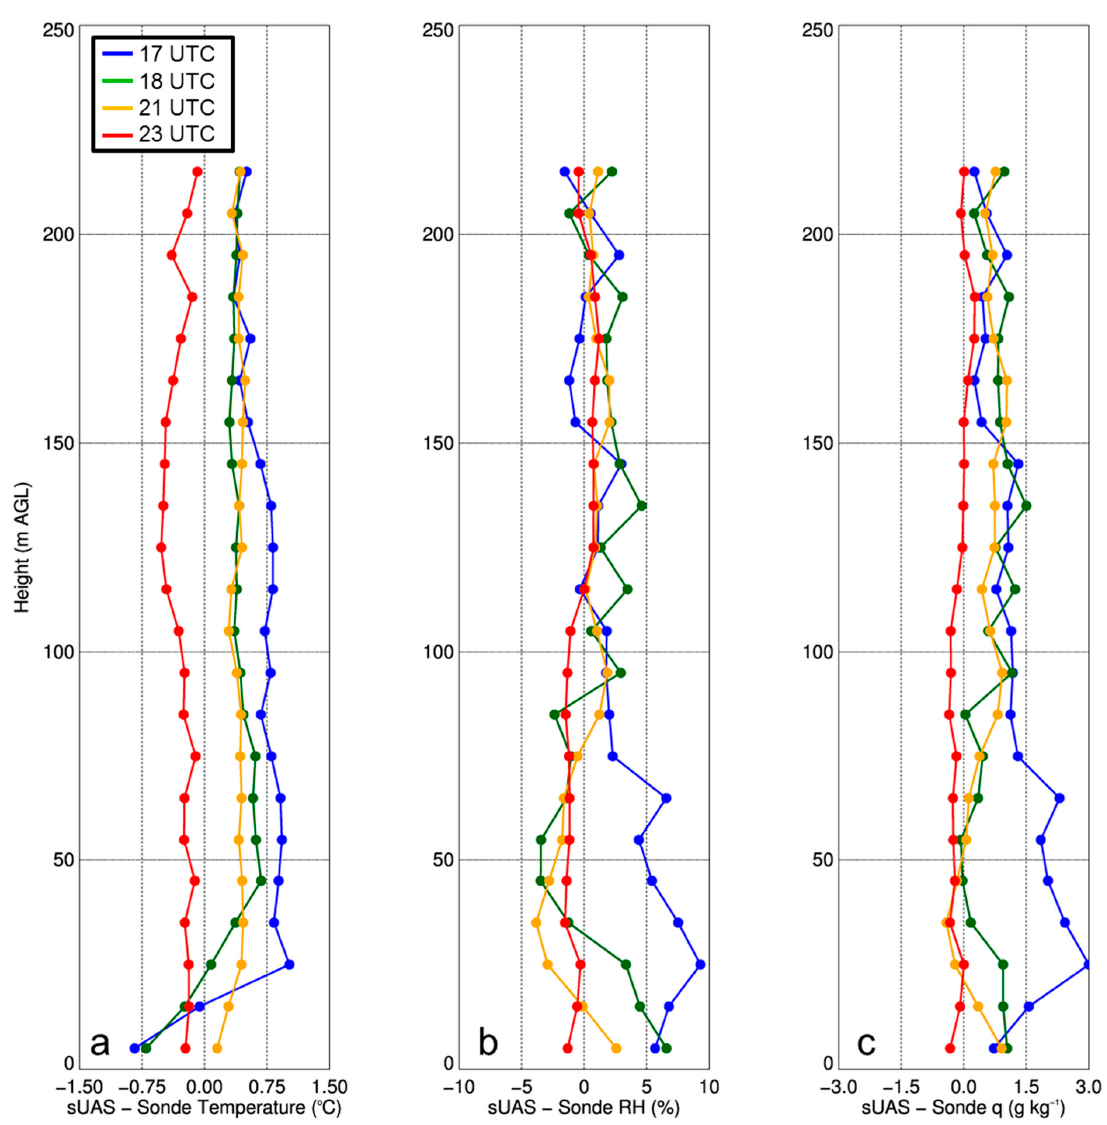
Figure 4. Difference between sUAS iMet-XQ temperature ( a ), relative humidity (RH) ( b ), and specific humidity (q) ( c ), and rawinsonde measurements at 1700 UTC, 1800 UTC, 2100 UTC, and 2300 UTC on 28 April 2017 from Cullman, AL. Data were averaged into 10-m bins.